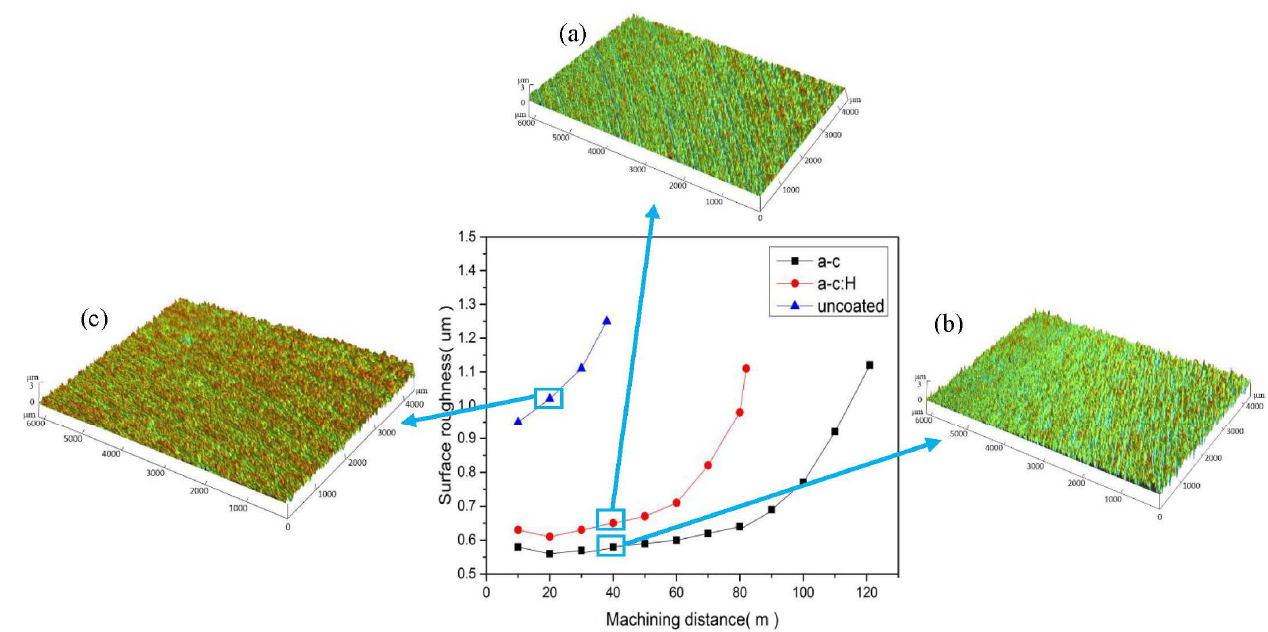
Figure 4. The relationship between machining distance and machined surface roughness: ( a ) a-C:H-coated tool, ( b ) a-C-coated tool, and ( c ) uncoated tool.